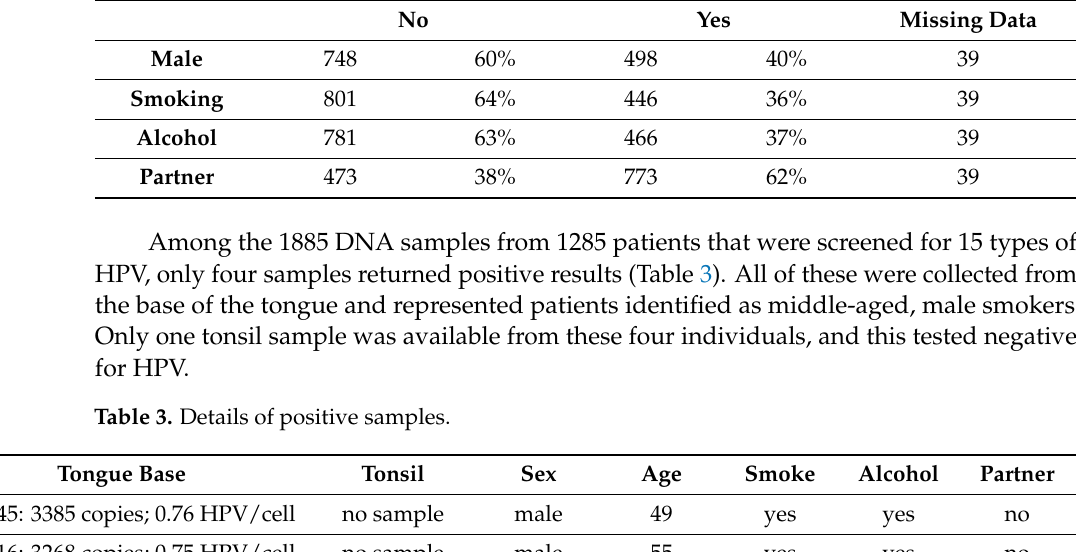
Table 2. Descriptive data of participants screened for HPV high-risk strains.